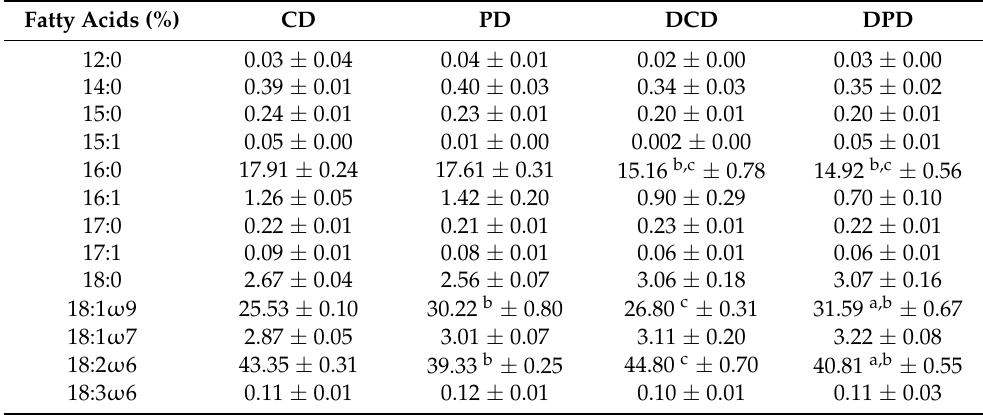
Table 2. Fatty acid profile of visceral adipose tissue in the four groups of animals. Fatty Acids